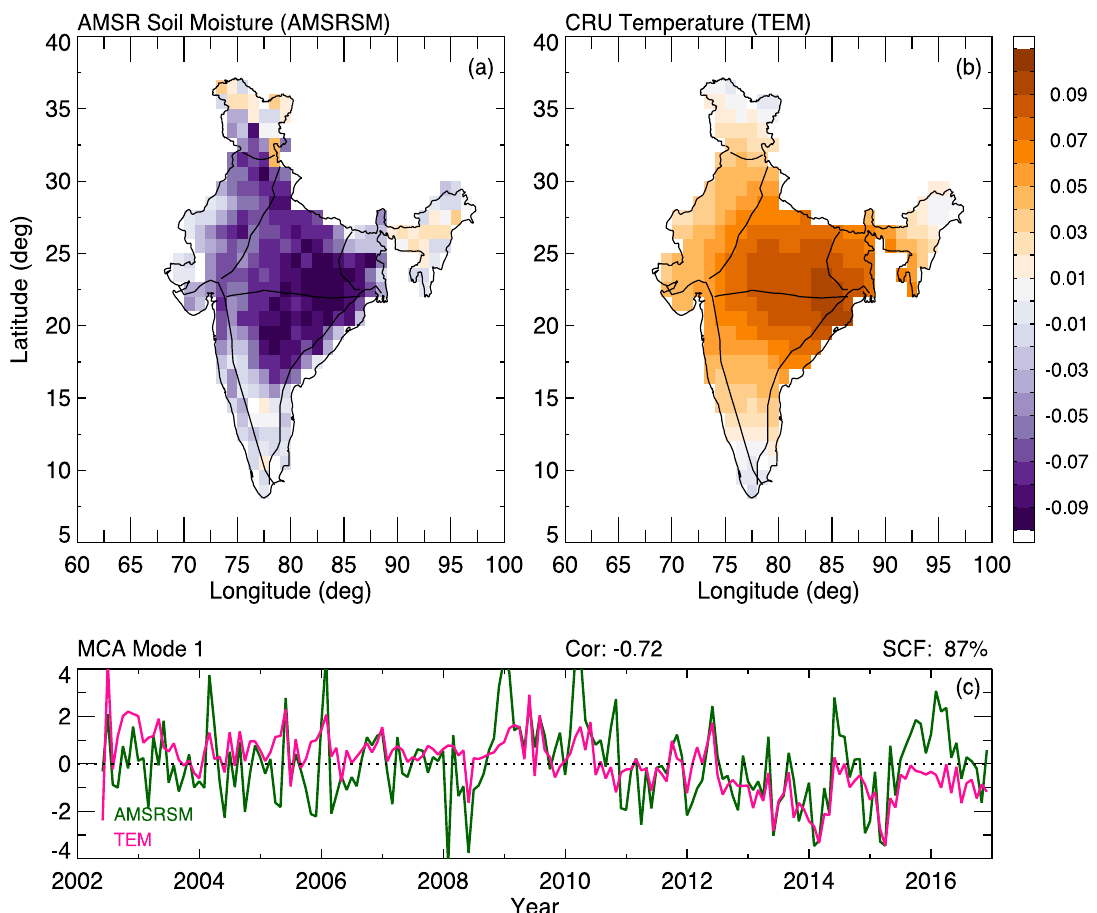
Figure 5. Spatial patterns of the first MCA mode associated with ( a ) AMSR soil moisture and ( b ) CRU temperature during the period 2006–2016. ( c ) The corresponding covariance coefficients associated with AMSR soil moisture (green curve) and temperature (pink curve). The squared coefficient factor (SCF) and correlation coefficients are indicated on the top of the plot.